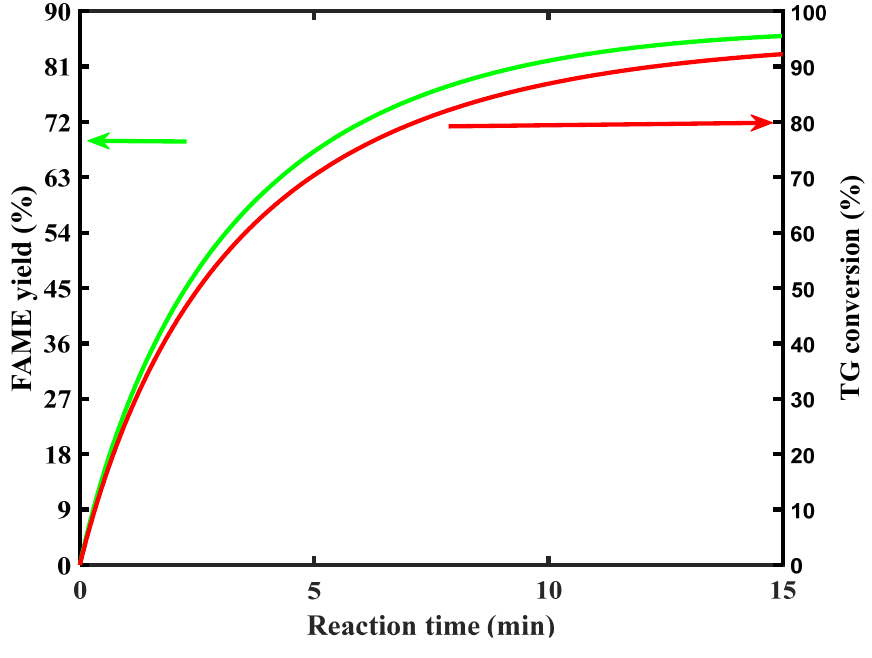
Figure 12. TG conversion and FAME yield.